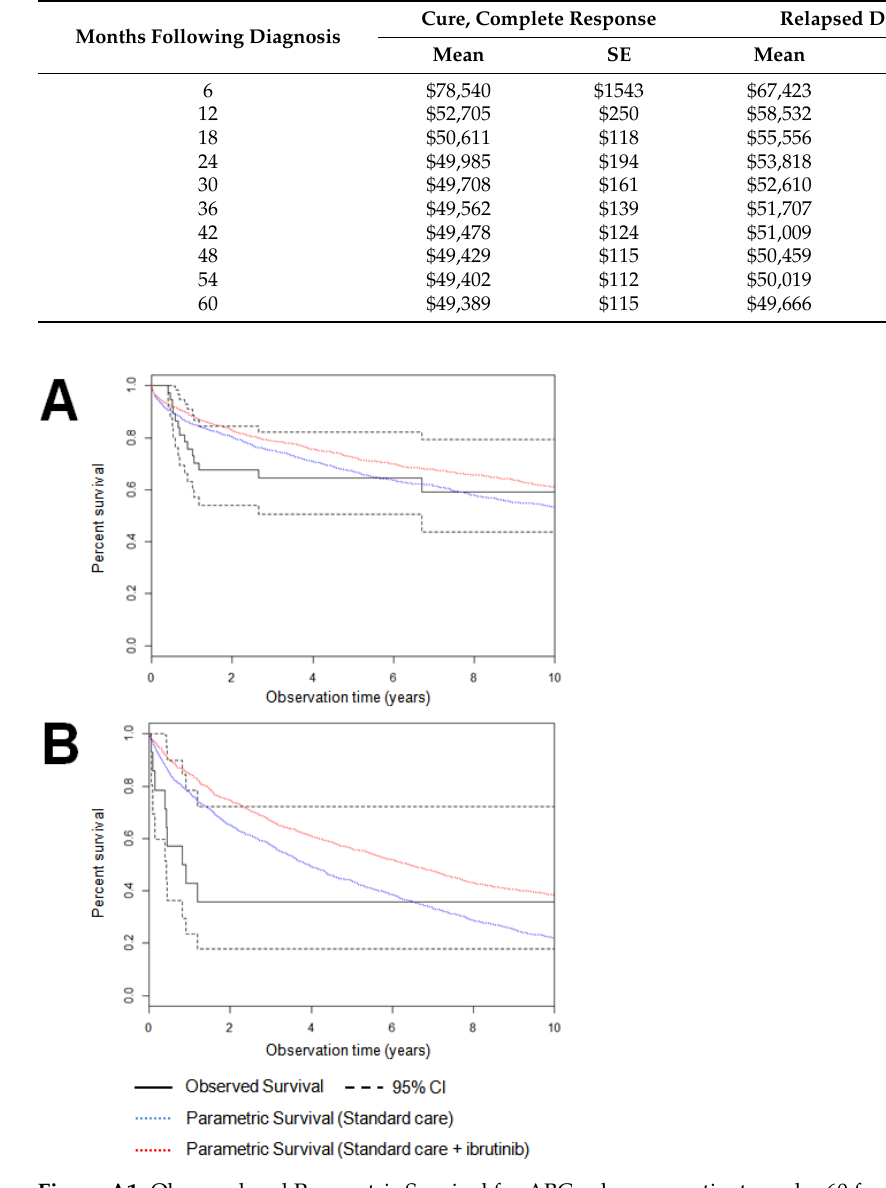
Figure A1. Observed and Parametric Survival for ABC subgroup patients under 60 for ( A ) Complete Response to Relapse, and ( B ) Relapse to Death.